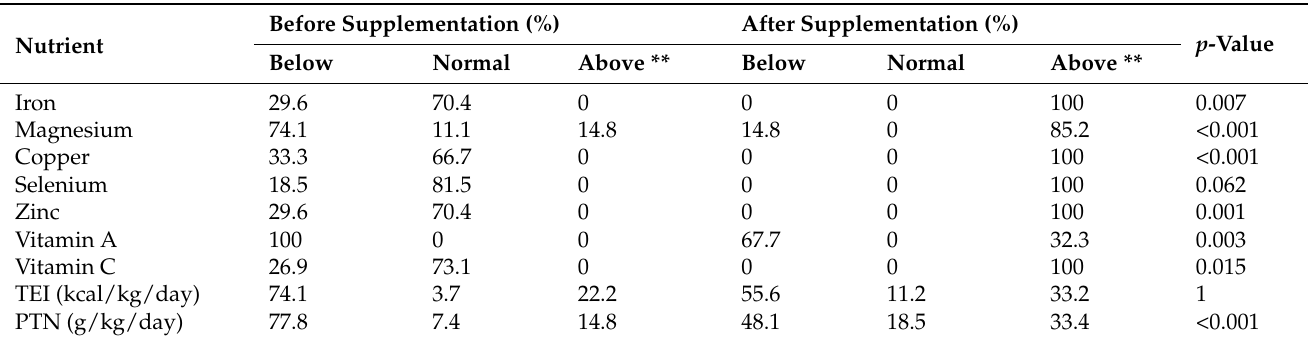
Table 3. Dietary intake of patients with venous ulcers before and after nutritional supplementation and comparison with dietary reference intakes *.